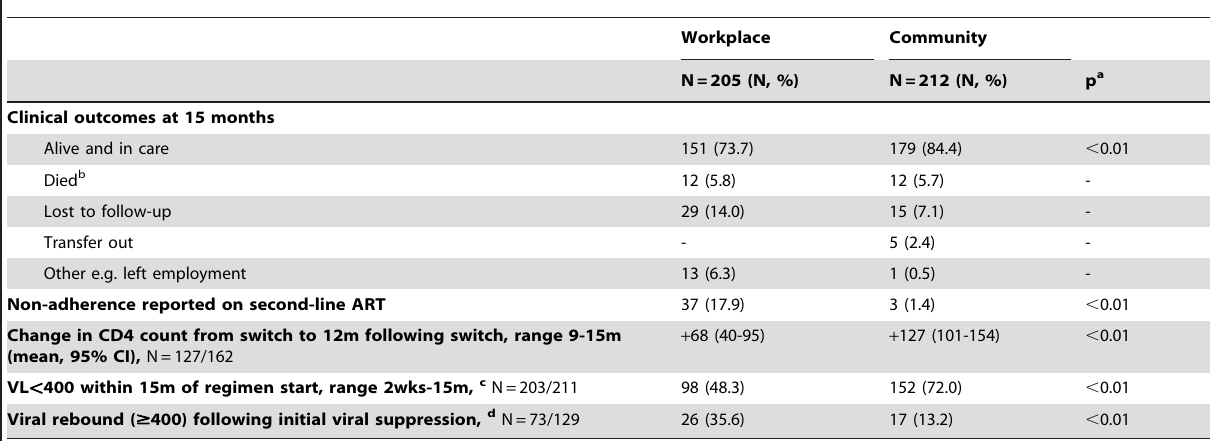
Table 2. Outcomes at 15 months of second-line